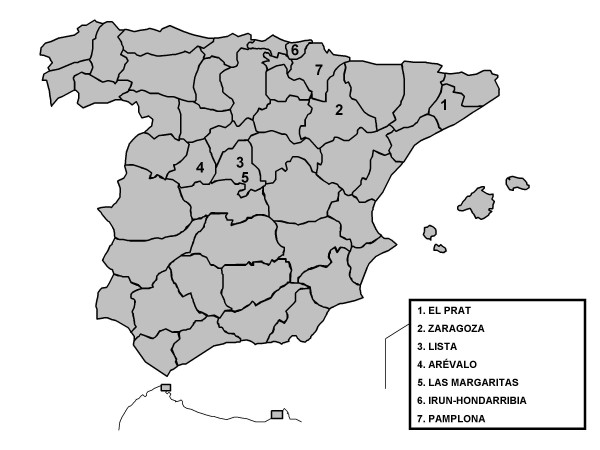
Geographic location of surveys.